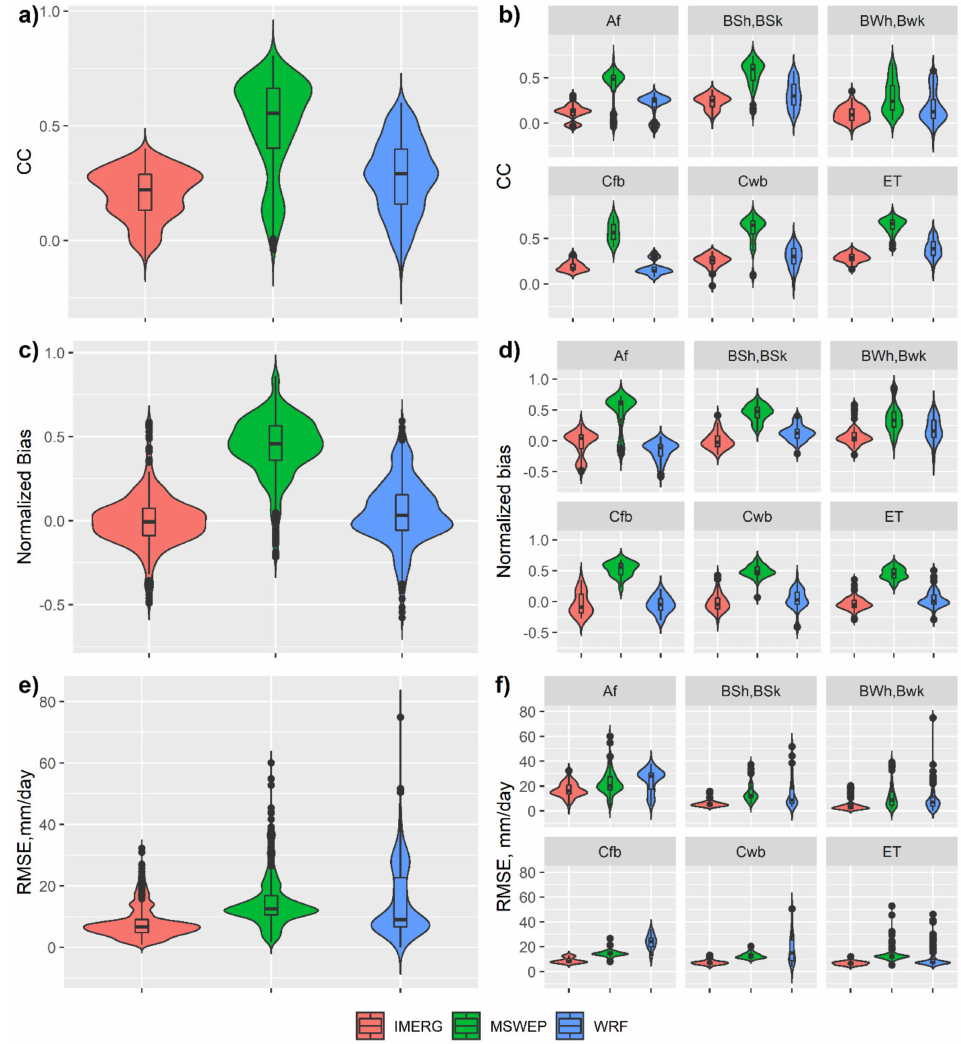
Figure 5. The violin plot of statistical results ( a , c , e ) from GPM IMERG, MSWEP, and WRF simulations in the Peruvian region. The subplots of statistical results in different climate zones are listed in ( b , d , f ). The cross bar in the inside box within the violin plot is the median, and the vertical length of the box indicates the confidence interval of the